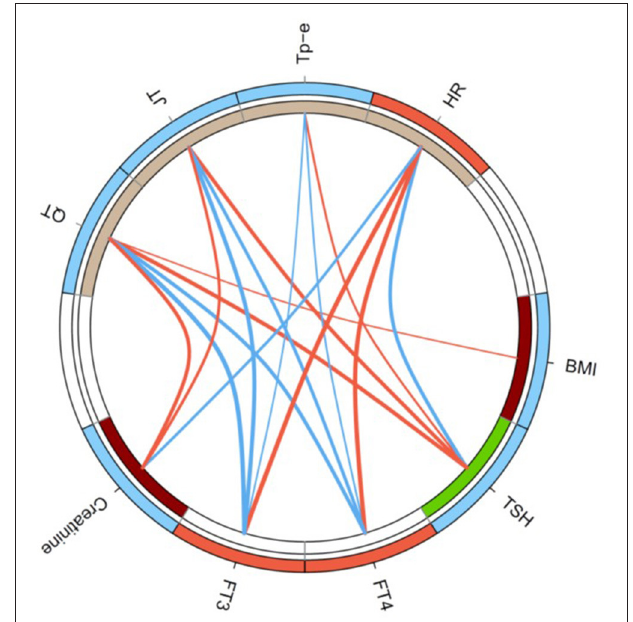
FIGURE 2 | Circular map of the univariable correlation network of ECG markers to clinical and endocrine parameters. Shown are significant correlations ( p < 0.05) only, and line thickness indicates the strength of negative (blue) or positive (red) correlation. Colors of circle segments indicate increased (red) or decreased values (blue), respectively, in thyrotoxicosis compared to hypothyroidism (outer ring) and higher (dark red) or lower values (green) in atrial fibrillation (inner